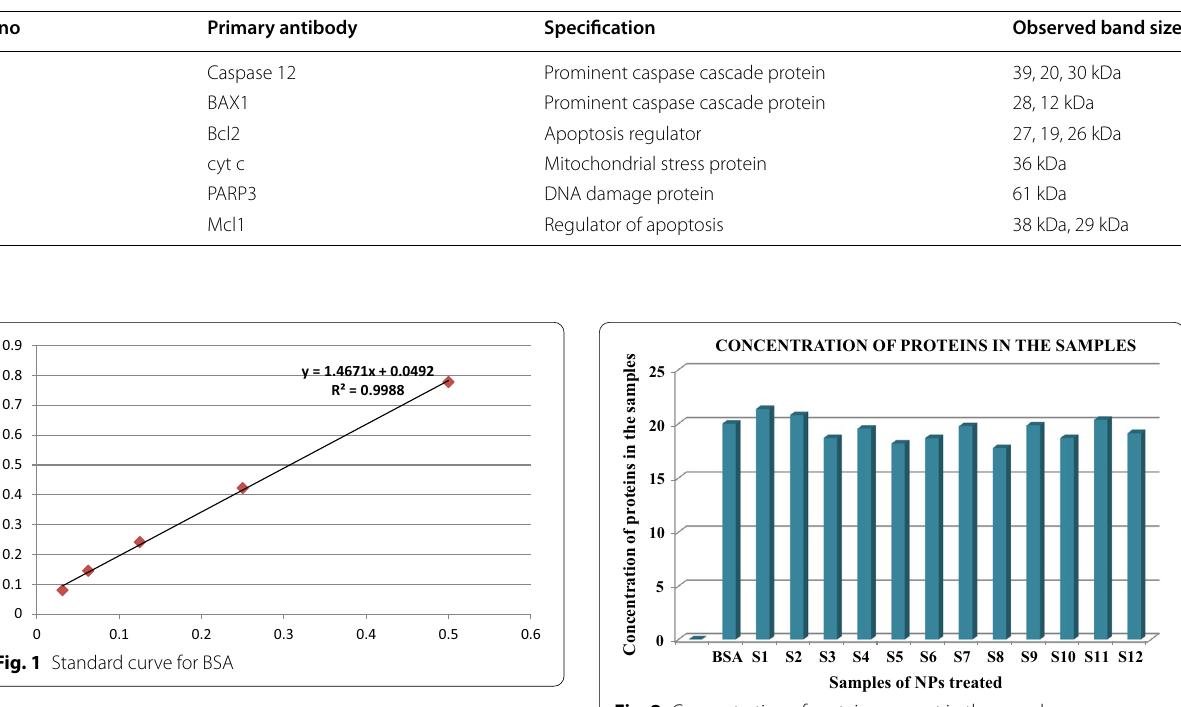
Fig. 2 Concentration of proteins present in the